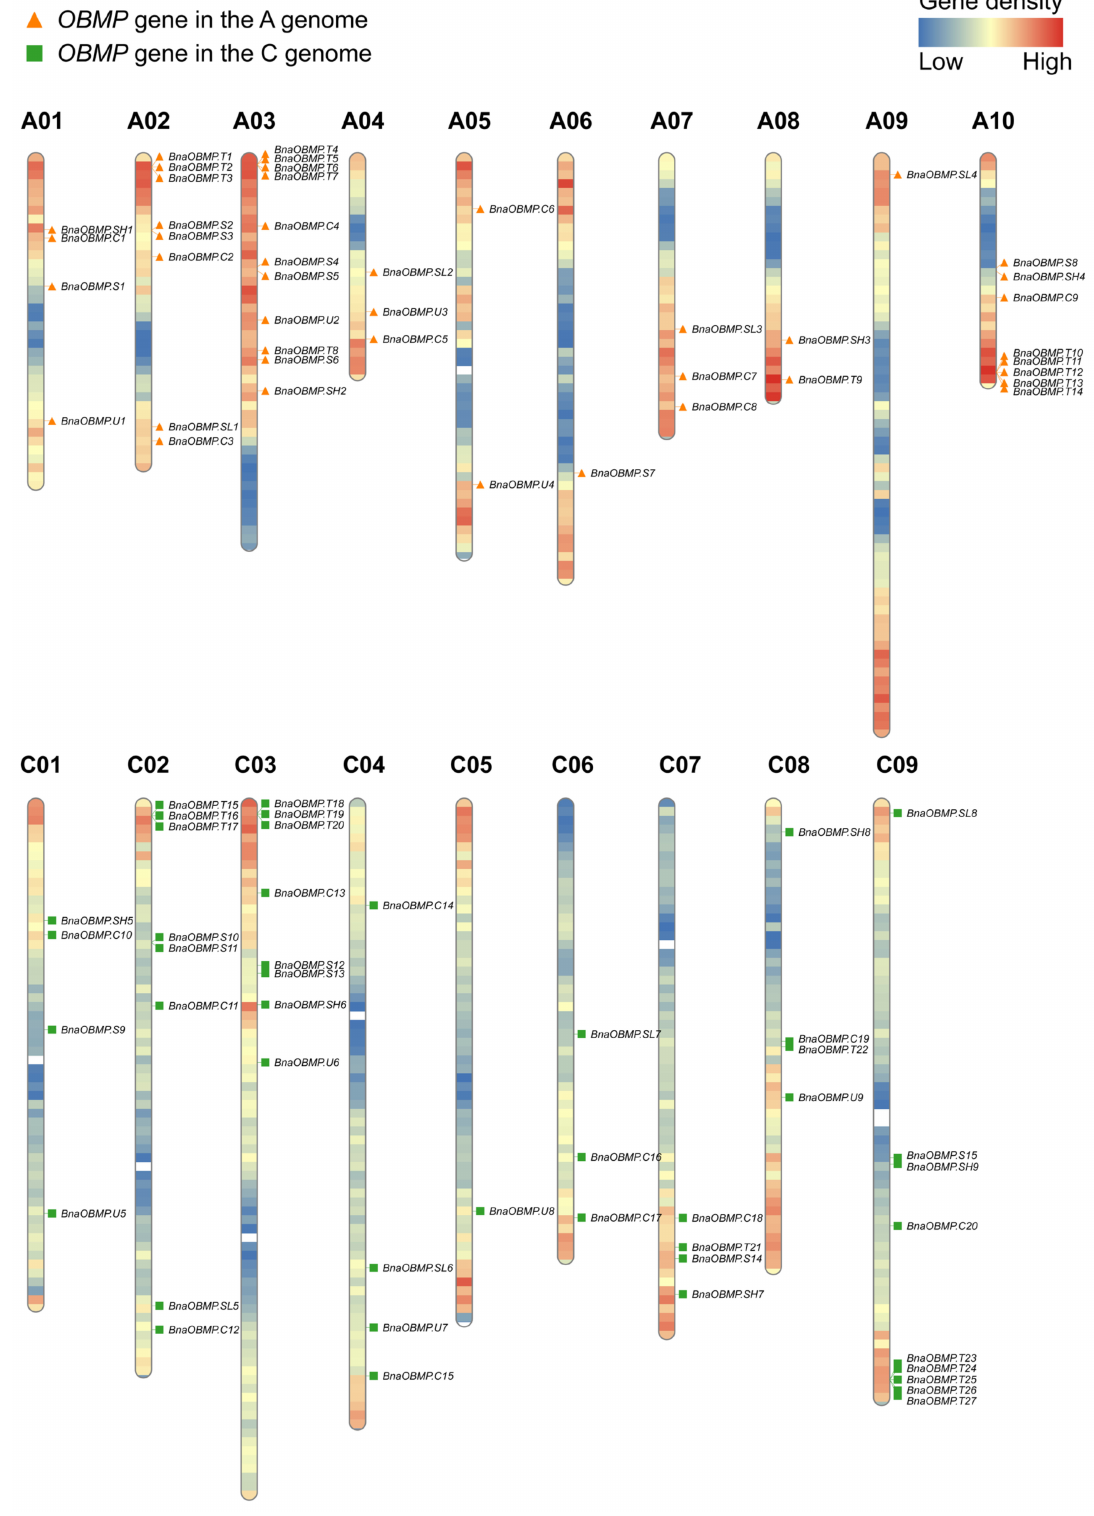
Figure 1. Genomic distributions of BnaOBMP genes on B. napus chromosomes. The BnaOBMPs were plotted based on the location of the genes and the length of the chromosomes. The orange triangles and green squares represent BnaOBMP genes in the A and C subgenomes, respectively. The color on each chromosome denotes the gene density from low (blue) to high (red) by the frequency per 1 mega base